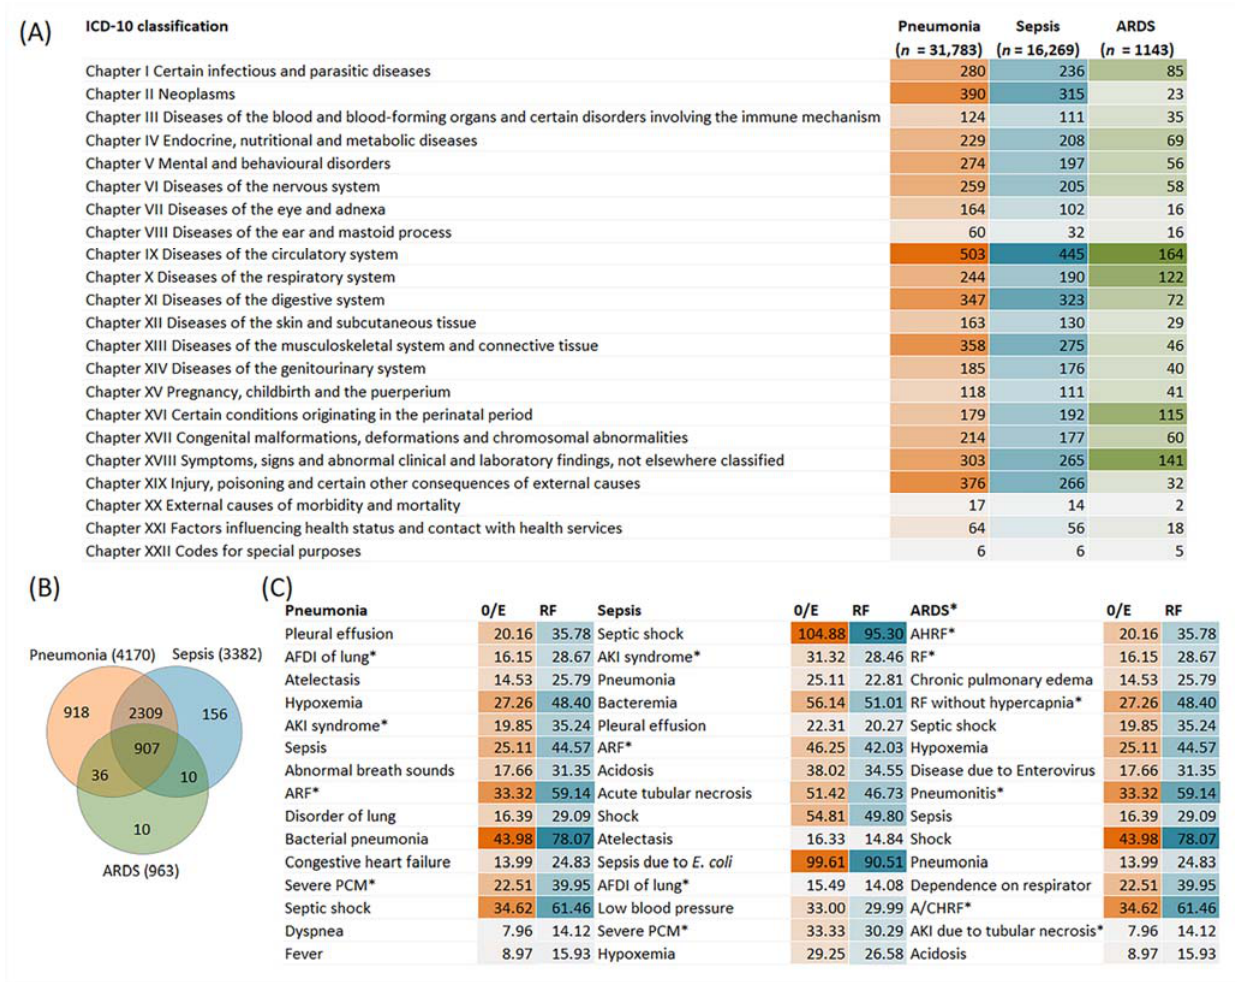
Figure 1. Summary of COHD data from the 5-year non-hierarchical dataset for clinical conditions co-occurring with pneumonia, sepsis and acute respiratory distress syndrome (ARDS). ( A ) The number of ICD-10 classifications for all significant associations according the range of codes in each chapter. ( B ) Venn diagram for co-occurring concepts sharing by pneumonia, sepsis and ARDS. Since each concept can be described by several ICD-10 codes, the total number of co-occurring conditions is less than the number of ICD-10 codes. ( C ) Observed-to-expected frequency ratios (O/E) and relative frequencies (RF) for the top 15 co-occurring conditions in accordance with the results of the χ 2 test. The natural logarithm of the O/E ratio has been converted back to the original scale. * Abbreviations: AKI, acute renal (kidney) failure; (A)RF, (acute) respiratory failure; A/CHRF, acute on chronic hypoxemic respiratory failure; AFDI, abnormal findings on diagnostic imaging of lung; AHRF, acute hypoxemic respiratory failure; PCM, protein–calorie malnutrition; Pneumonitis, pneumonitis due to inhalation of food or vomitus.